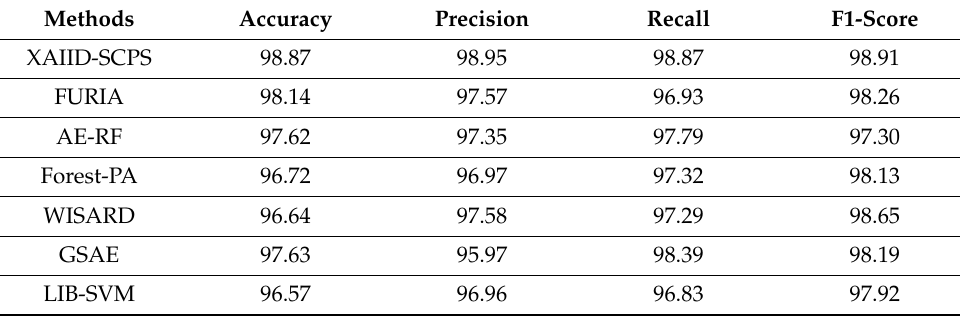
Table 4. Comparative outcome of XAIID-SCPS system with other systems.